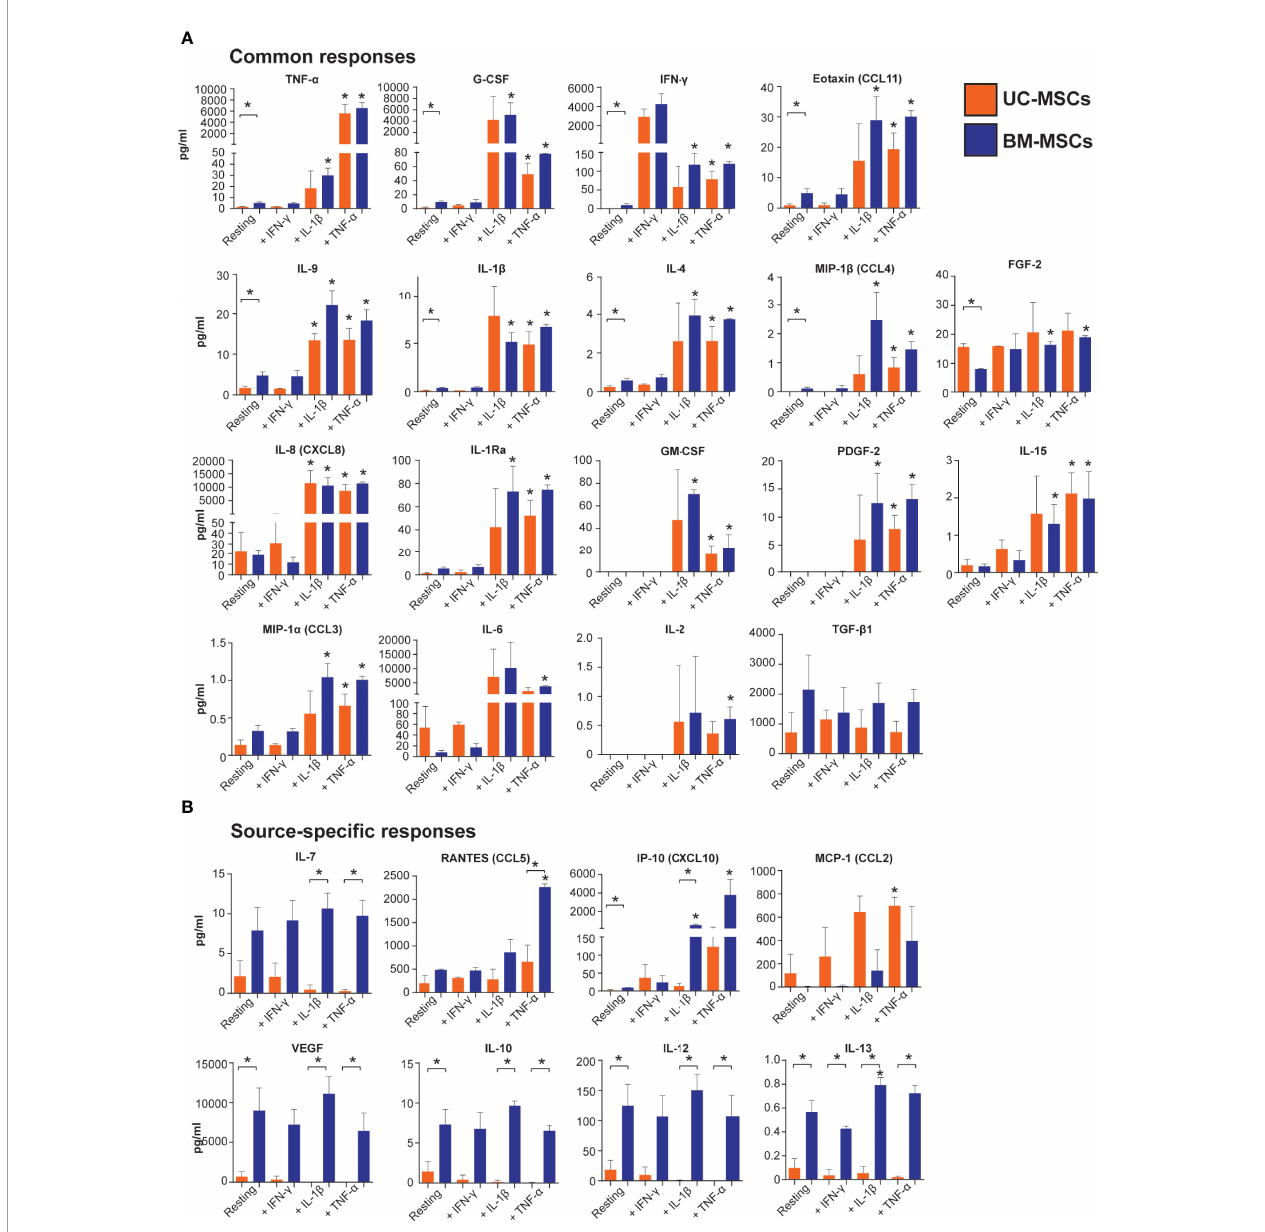
FIGURE 5 | Output of in fl ammatory mediators by licensed UC and BM-MSCs has some source-speci fi c differences. (A) Eighteen proteins exhibited similar expression patterns in unstimulated and licensed MSCs. (B) Nine proteins displayed source-speci fi c expression patterns. Seven proteins were speci fi cally produced at signi fi cantly higher concentrations by licensed BM-MSCs, while MCP-1 was uniquely upregulated by activated UC-MSCs. Protein concentration was normalized to per million cells at harvest after 24-hour activation. Bracketed asterisks denote signi fi cantly different means between MSC types, and unbracketed asterisks denote signi fi cantly different means between activated and resting MSCs of the same type, as determined by FDR-adjusted p<0.05. BM, bone marrow; MSC, mesenchymal stromal cell; UC, umbilical TNF- a and IL-1 b . Intriguingly, regulating synaptic membrane exocytosis protein 2 ( RIMS2 ) was only induced in UC-MSCs following IFN- g exposure, while several human leukocyte antigen (HLA) receptors, involved in antigen presentation, and toll like receptor 2 ( TLR2 ), which recognizes pathogenic peptides, were speci fi cally upregulated in BM-MSCs.